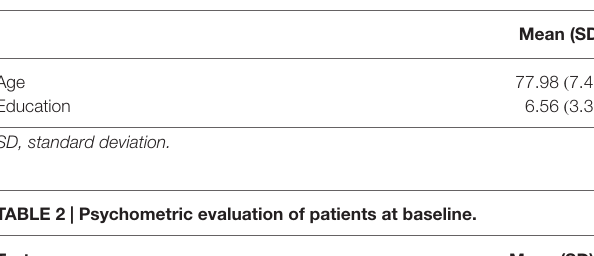
TABLE 1 | Demographic characteristics of 86 participants (75% female) at baseline.